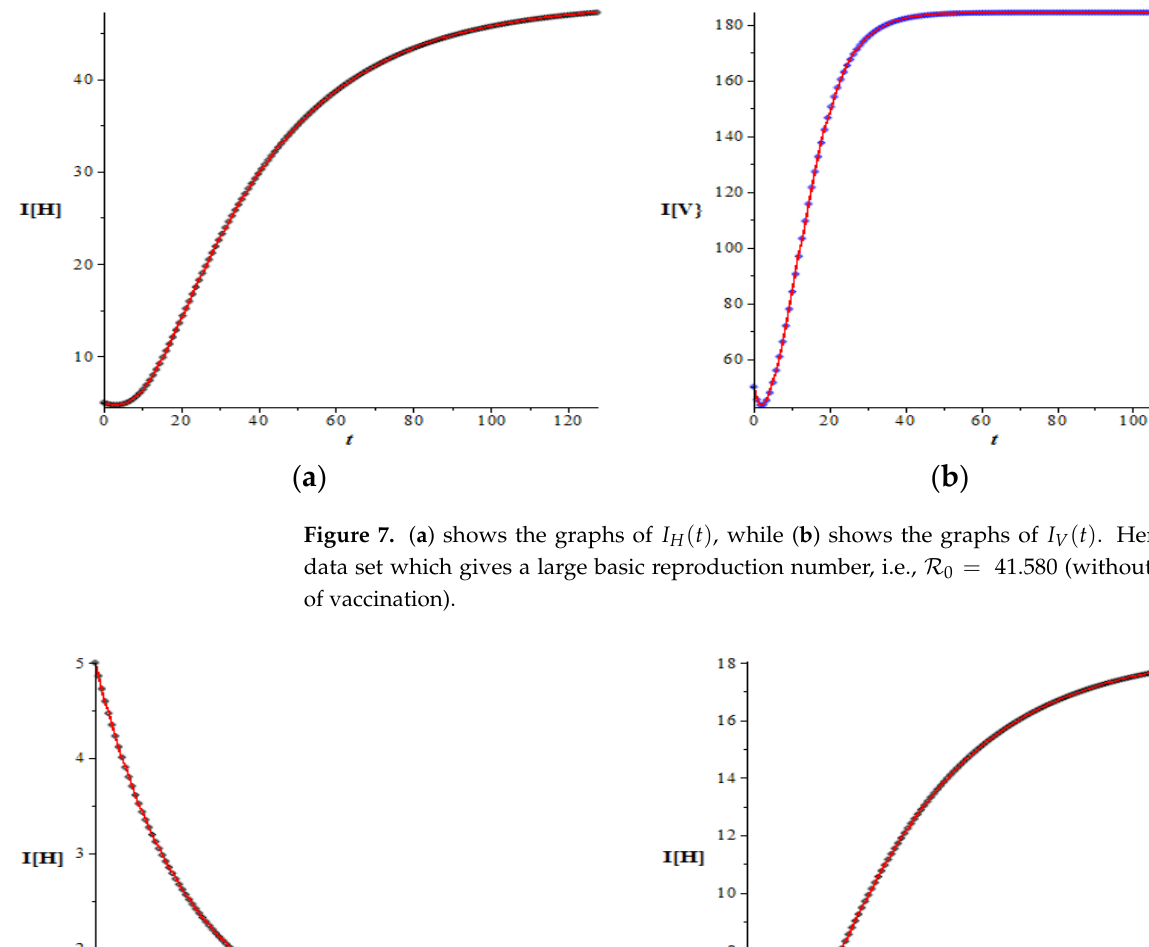
Figure 8. ( a ) shows the graphs of I H ( t ) if 98% of the susceptibles are vaccinated, while ( b ) shows the graphs of I H ( t ) if only 60% of the susceptibles are vaccinated. In the former, the resulting effective reproduction number is 0.832, while, in the latter, the resulting effective reproduction number is 16.632. In this section, we consider a vaccination with a decaying effect. As before, it is assumed that the host population is vaccinated at birth, as much as p portion, and is removed to the immune class P H . However, it is also assumed that the vaccination has a decaying effect where e − τ a is the survival from losing immunity of an individual of age a . Hence, the number of immune individuals at time t is given